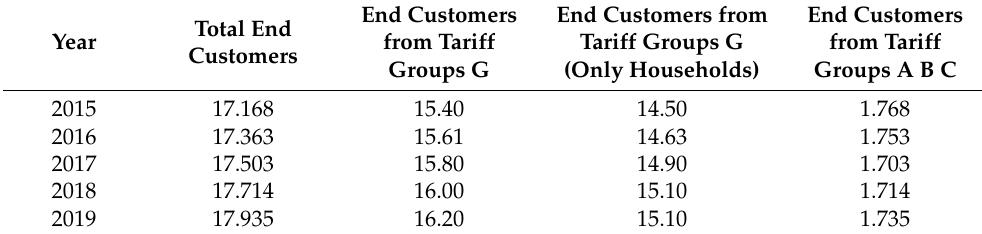
Table 1. Final consumers of electricity in Poland according to tariffs (in million).